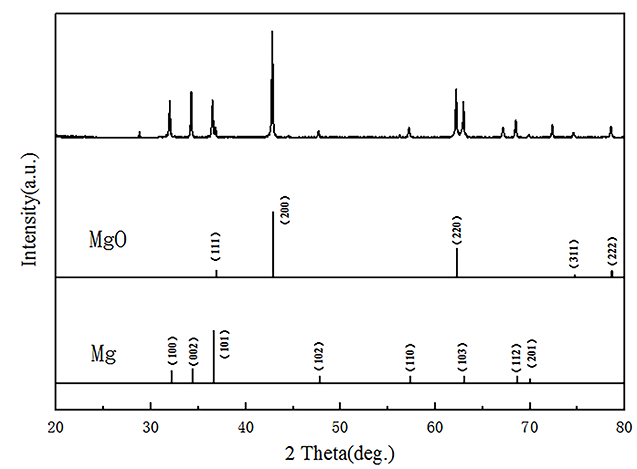
Figure 4. XRD image of micro-arc MgO